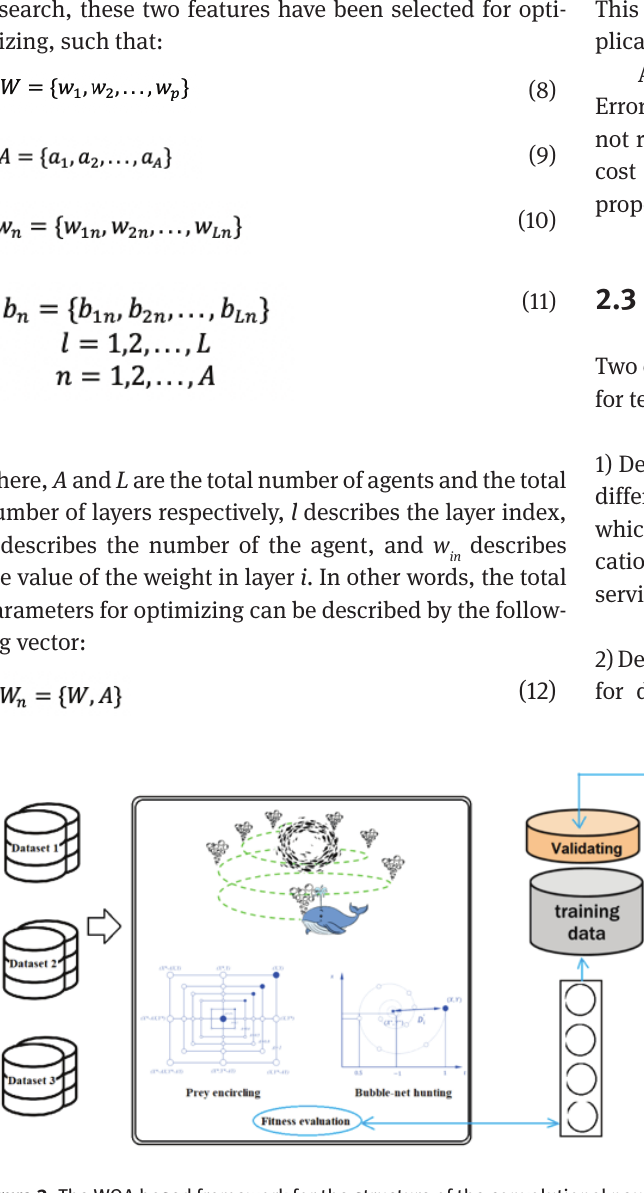
Figure 3: The WOA based framework for the structure of the convolutional neural